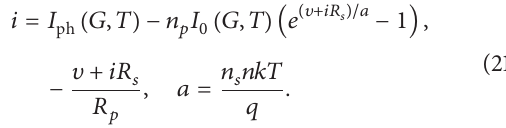
Figure 4: Electrical behavior of the boost